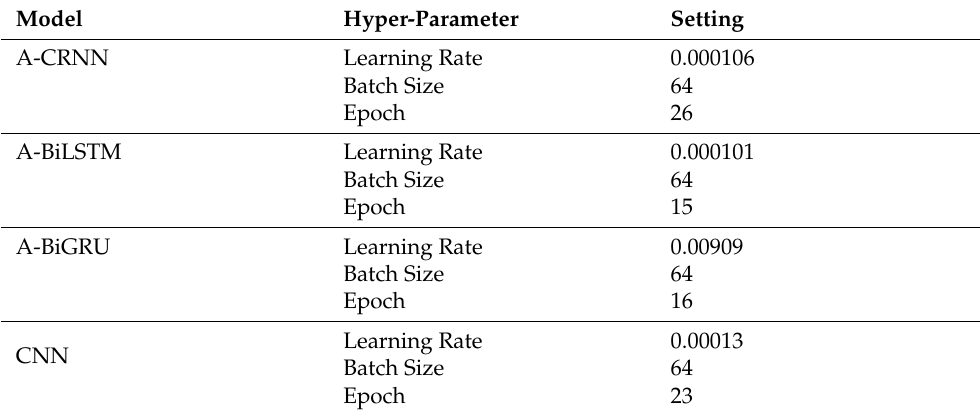
Table 10. Optimized hyper-parameter settings with respect to